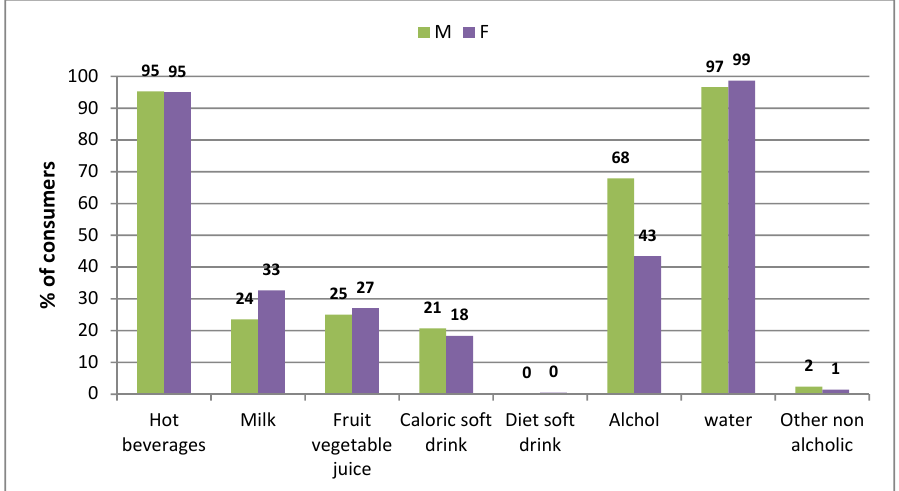
Figure 2. Popularity of beverages (% consuming over 3 days).